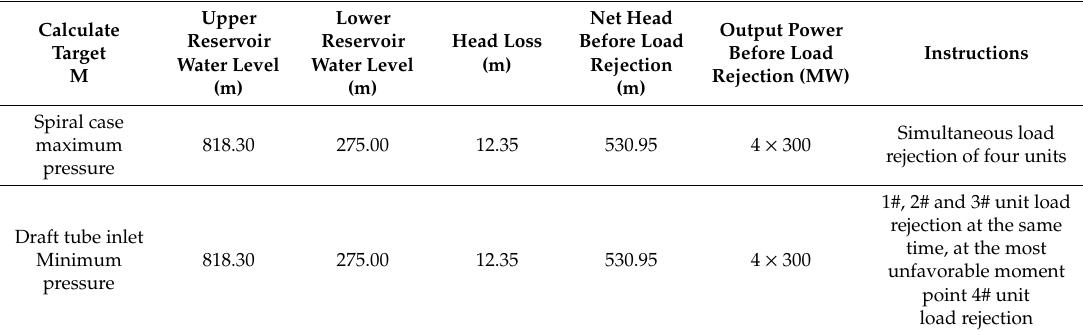
Table 6. Numerical simulation calculation conditions of control conditions.